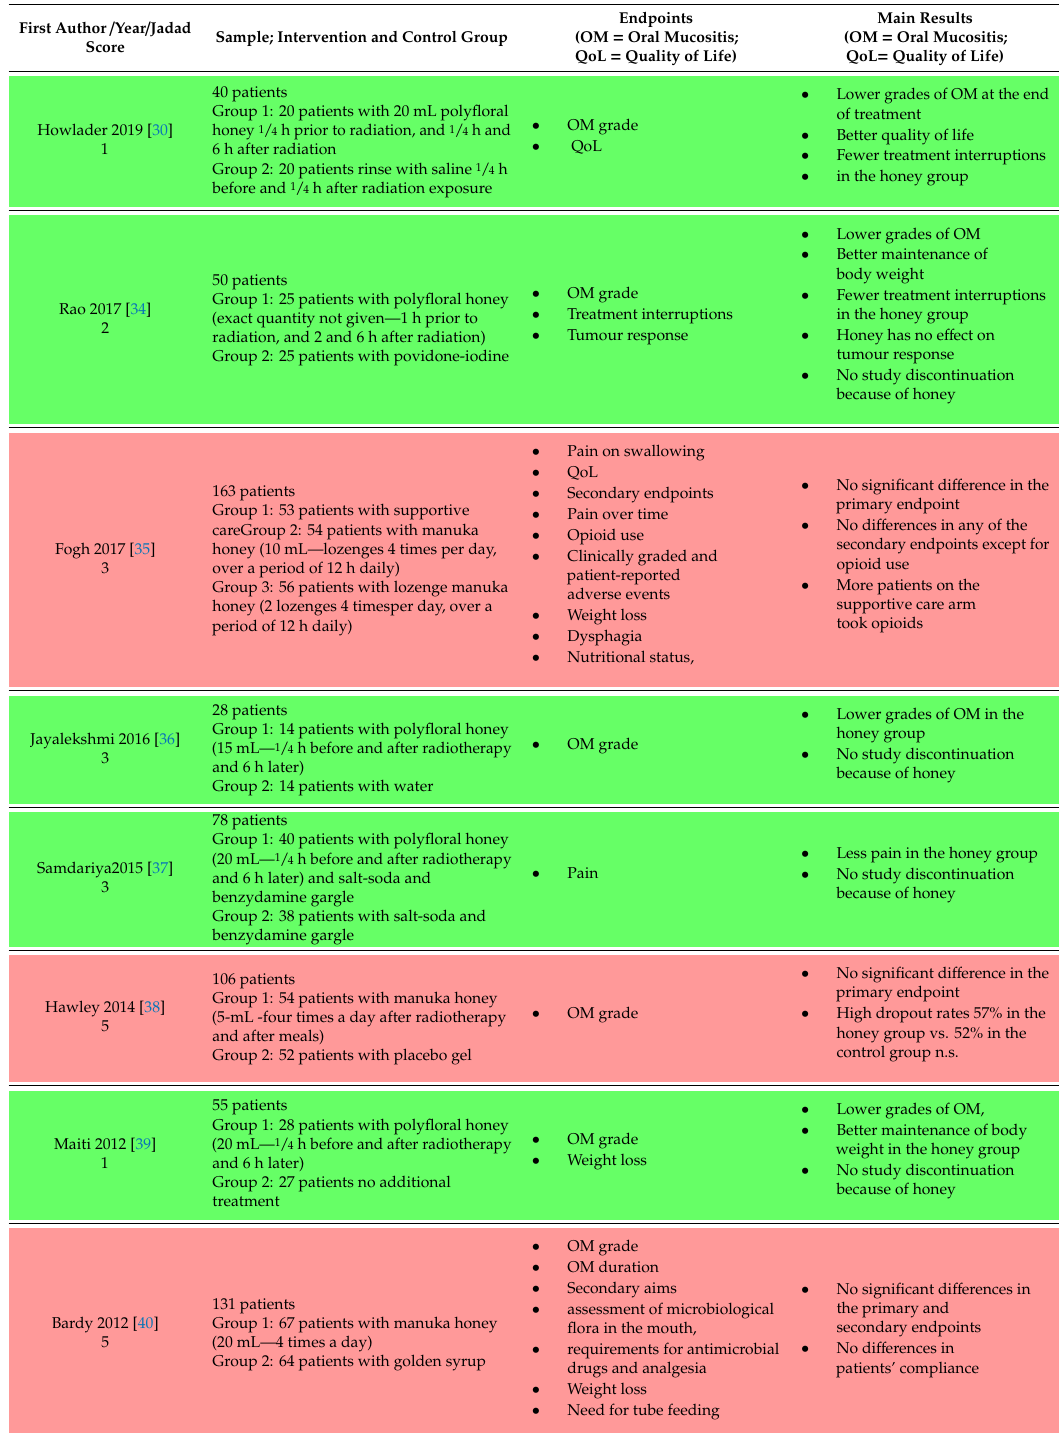
Table 2. Summary of randomized trials on honey and the combination of chemotherapy and radiation therapy. (Studies highlighted in green mean positive results for honey, studies highlighted in red mean negative results for honey.) Note: All studies on manuka honey had negative